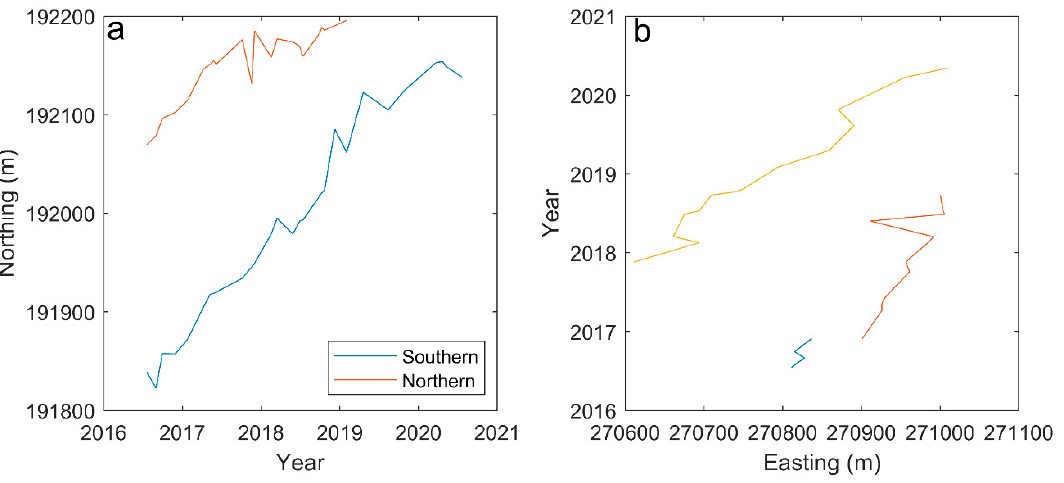
Figure 12. Migration of sandbar centroids: ( a ) cross-shore migration of the two main crescentic sand bars; ( b ) longshore migration rates of the smaller sandbars that detach from the cresenetic bars.